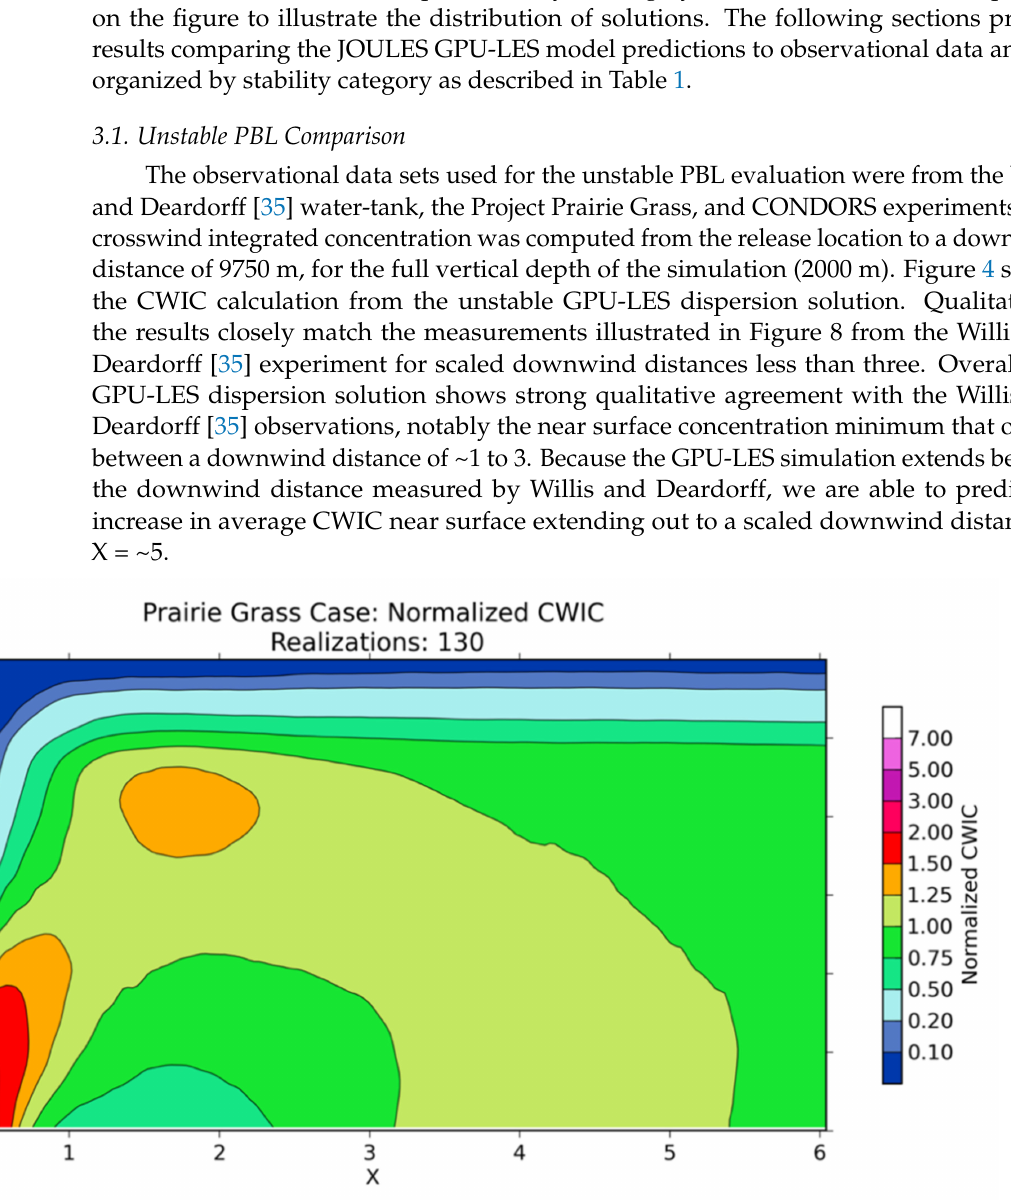
Figure 4. Normalized crosswind integrated concentration as a function of the downwind distance from the release location. This figure and corresponding calculation are frequently used in the atmospheric dispersion community to compare dispersion simulations to observational data. The plot represents the average CWIC from 130 individual GPU- LES